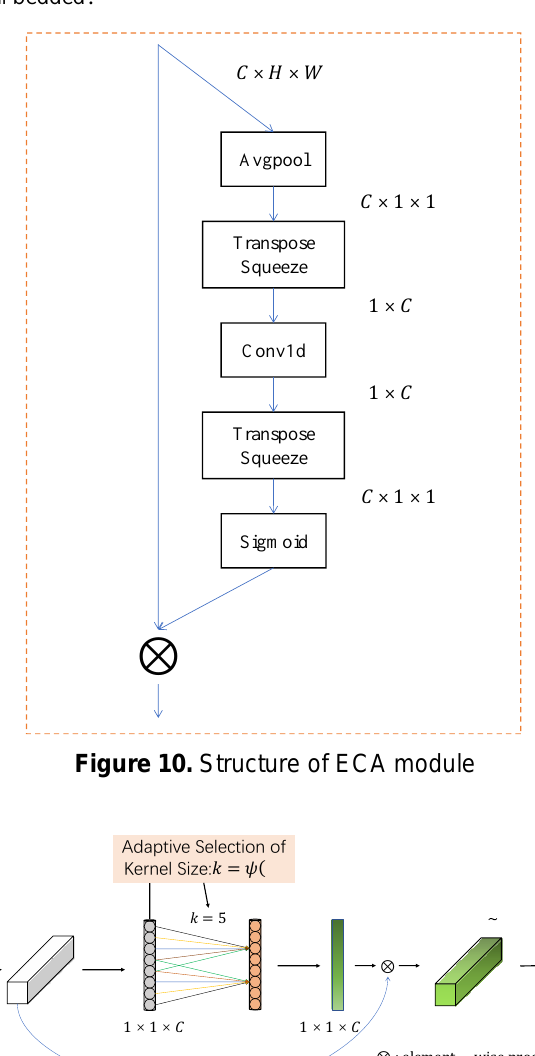
Figure 11. ECA module